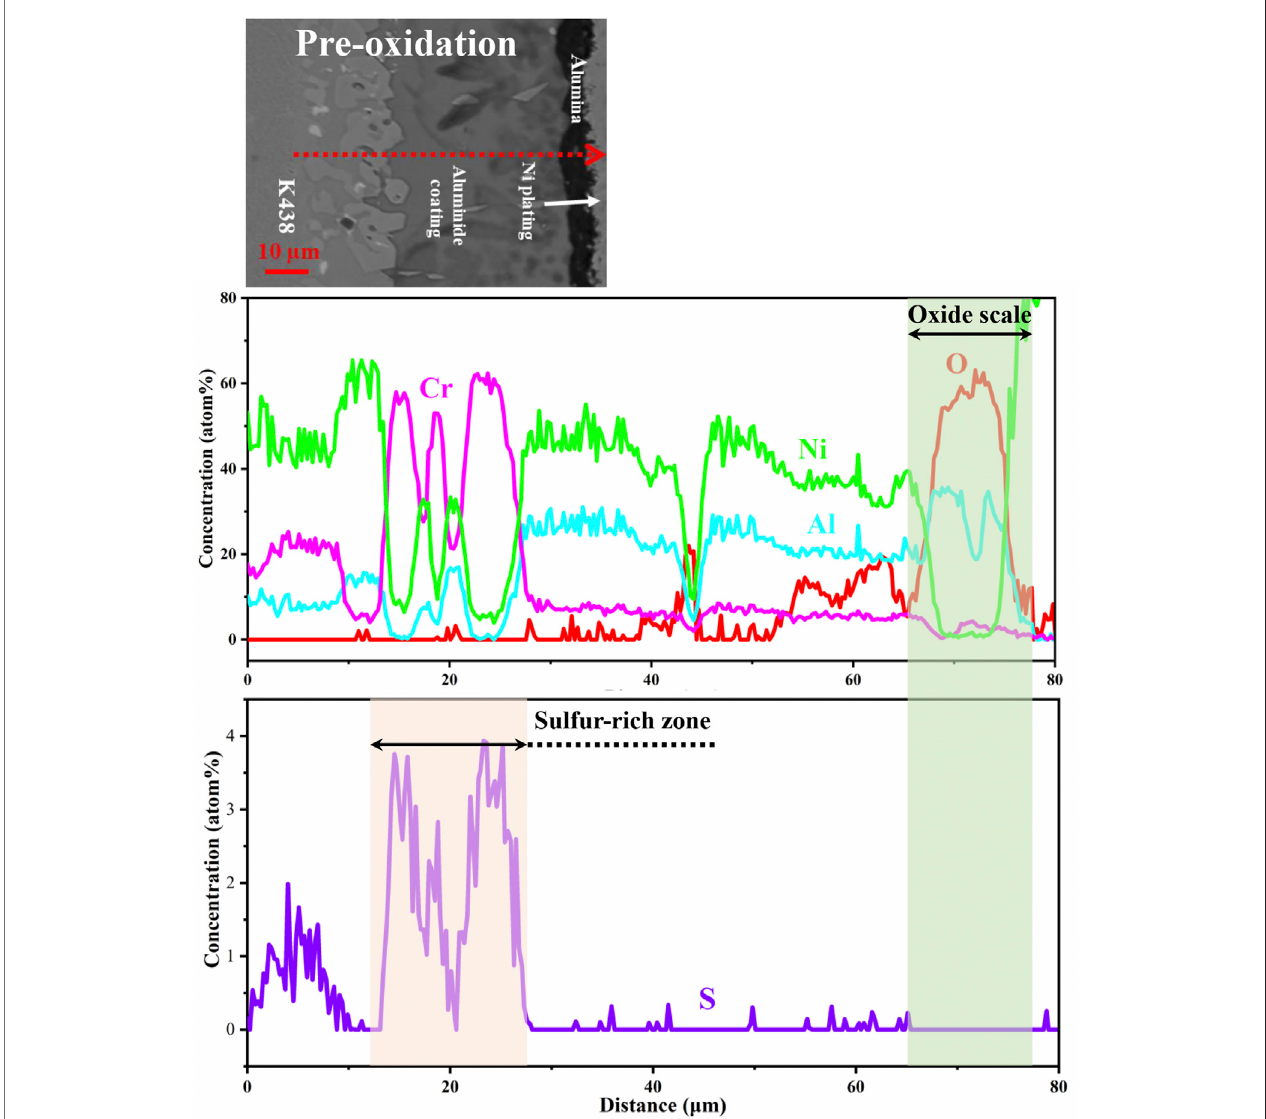
FIGURE 7 | Line scan of the pre-oxidation aluminide coating cross section after hot corrosion for 120 h in Na 2 SO 4 salt at 1050 ° C.